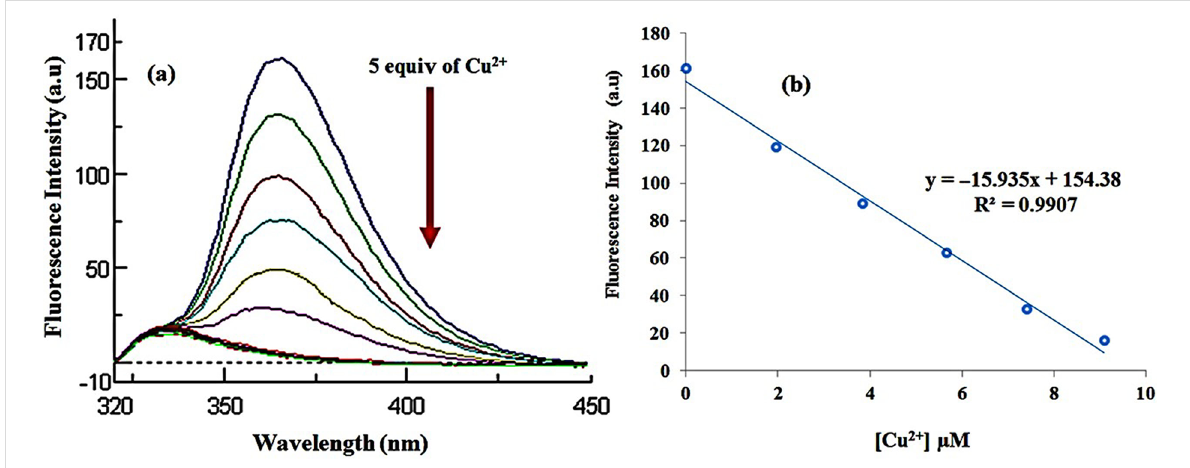
Figure 5: (a) Fluorescence spectra (1.0 × 10 − 5 M) of L recorded upon the addition of copper ion (0–5 equiv) in MeCN; excitation at 280 nm and emis- sion at 365 nm. (b) Calibration curve of fluorescence intensity of L with Cu 2+ ion concentrations.